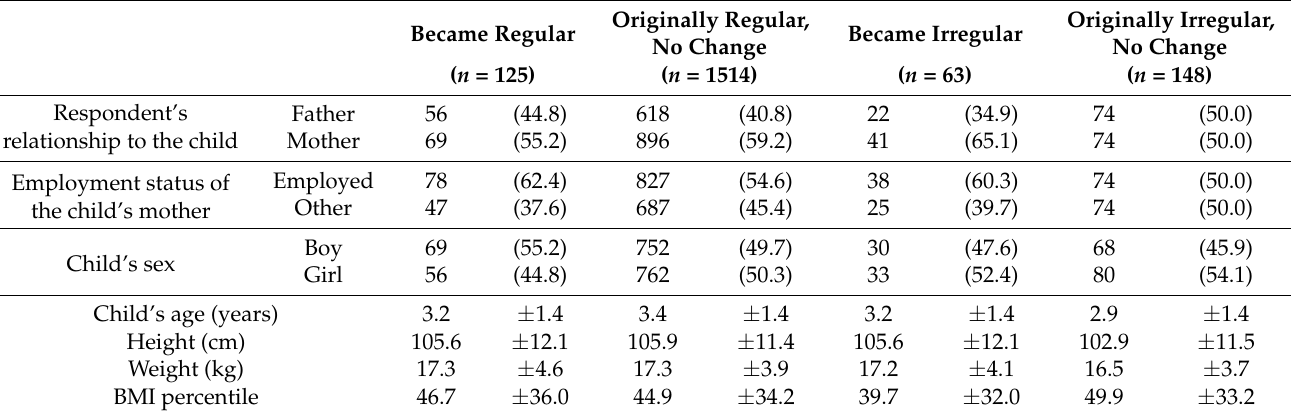
Table 1. Participant characteristics according to changes in mealtime regularity compared with before COVID-19.